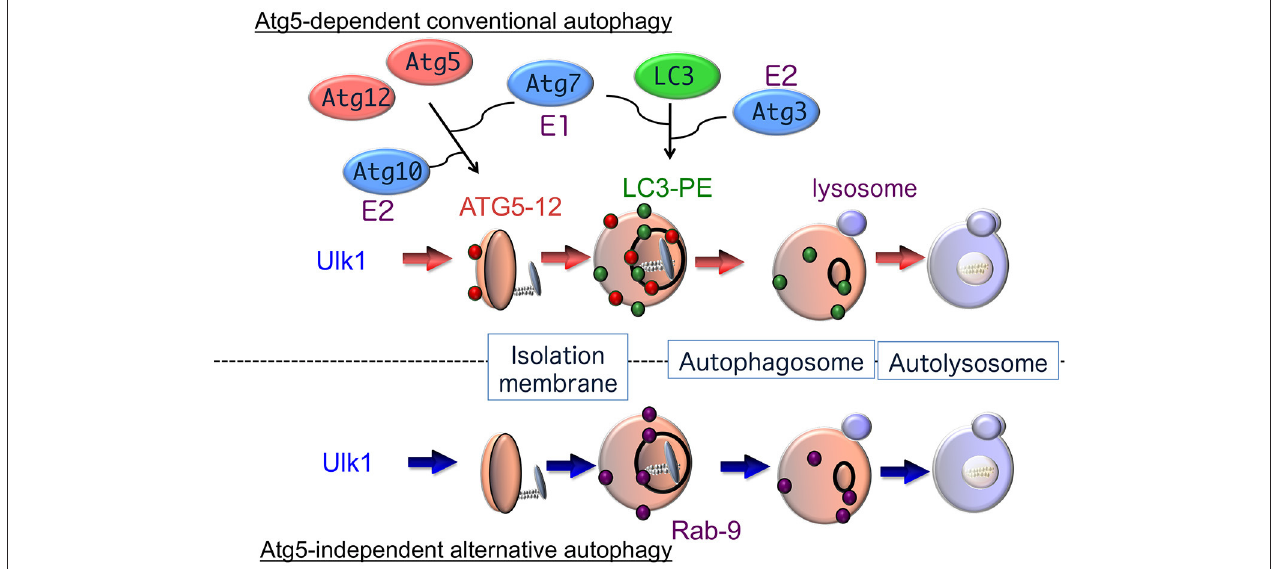
FIGURE 1 | Hypothetical model of autophagy. There are at least two modes of macroautophagy, i.e., conventional and alternative autophagy. Conventional autophagy requires Atg5 and Atg7, is associated with LC3 modification, and is thought to originate from the ER membrane. After Ulk1 stimulation, Atg5-12 complexes (red circles) attach to isolation membranes, and then LC3-PE puncta (green circles) are incorporated into autophagosomal membranes. In contrast, alternative autophagy occurs independently of Atg5 and Atg7, as well as LC3 modification. The generation of autophagic vacuoles in alternative autophagy is mediated by the fusion of isolation membranes with vesicles derived from the trans -Golgi as well as late endosomes, in a Rab9-dependent manner. After Ulk1 stimulation, Rab9 puncta (purple circles) attach to autophagic